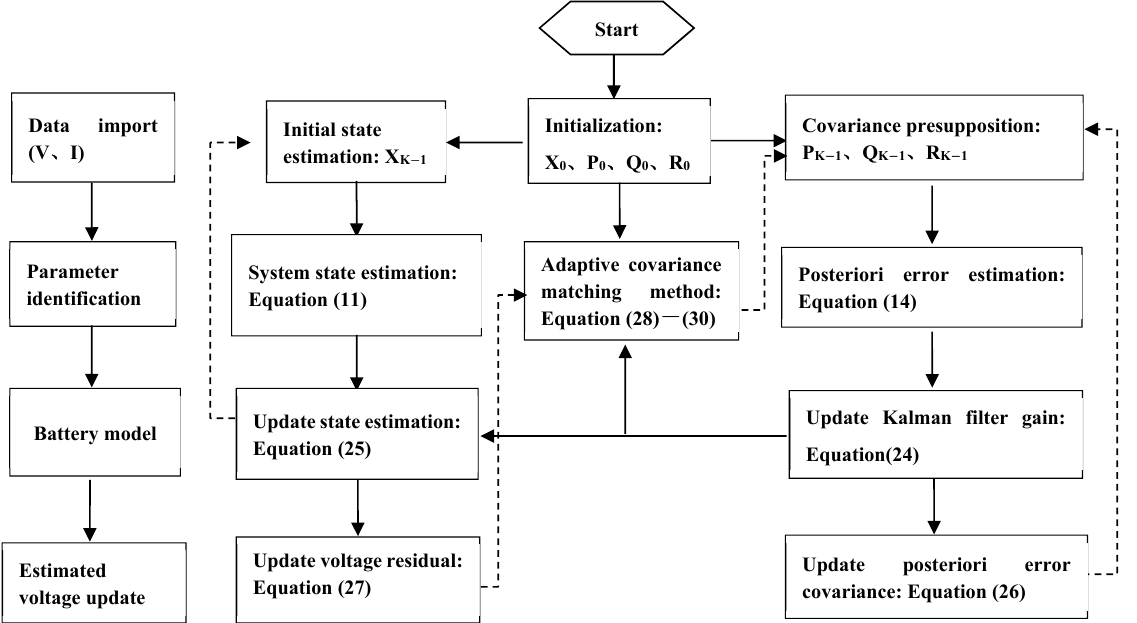
Figure 7. Flowchart of the adaptive unscented Kalman filter